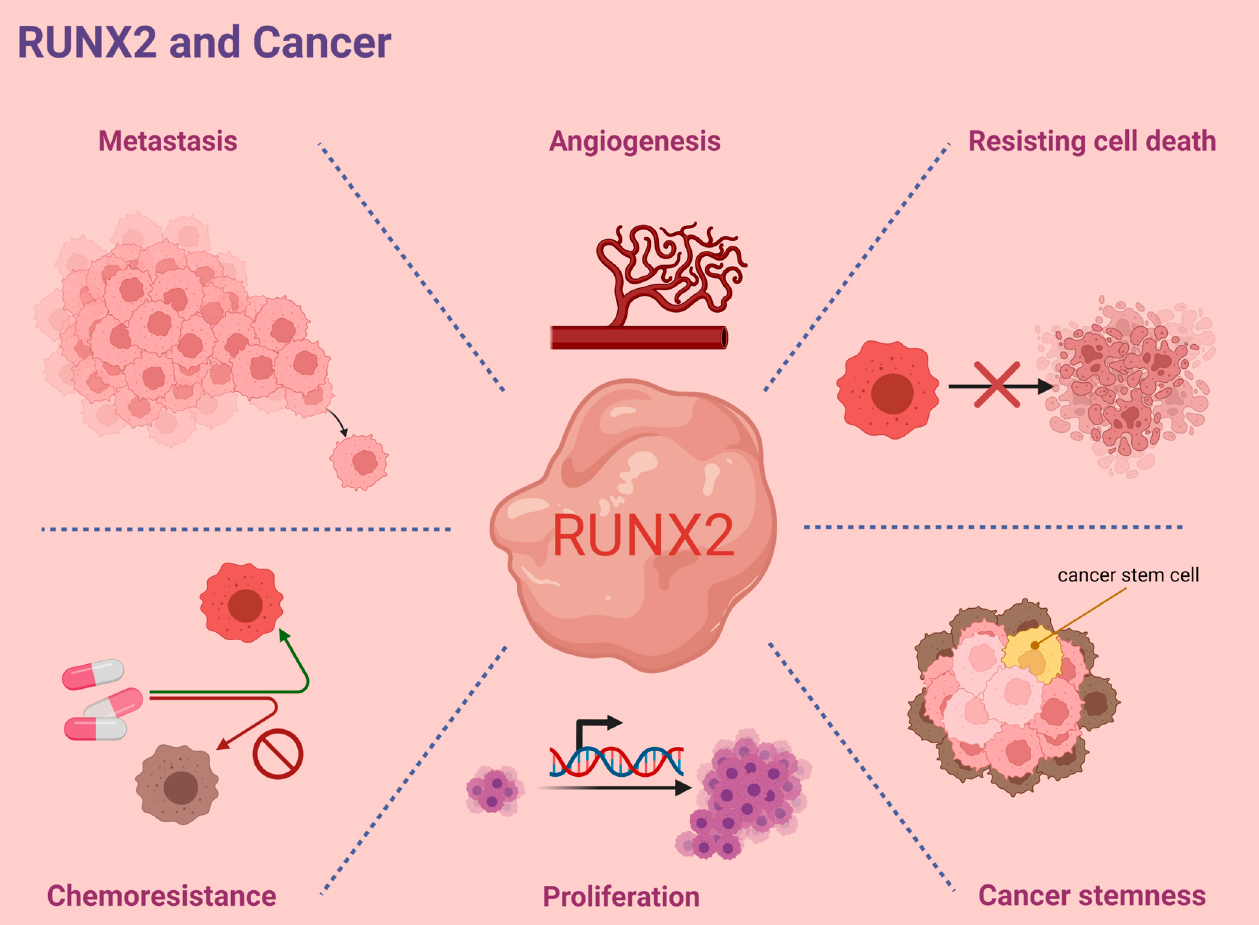
Figure 6. Representative scheme of RUNX2 ′ s modulations to hallmarks of cancer.